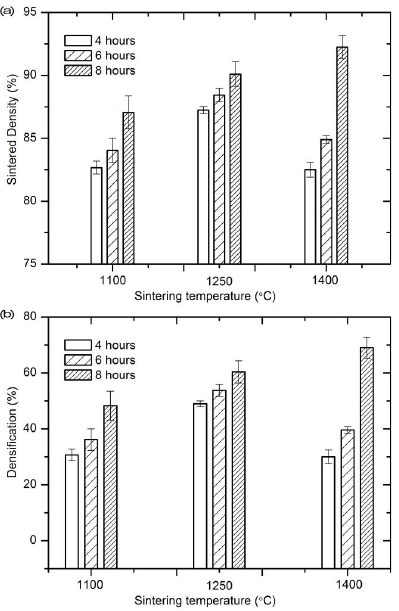
Figure 2. Effects of sintering temperature and holding time on relative sintered density ( a ) and densification parameter ( b ).